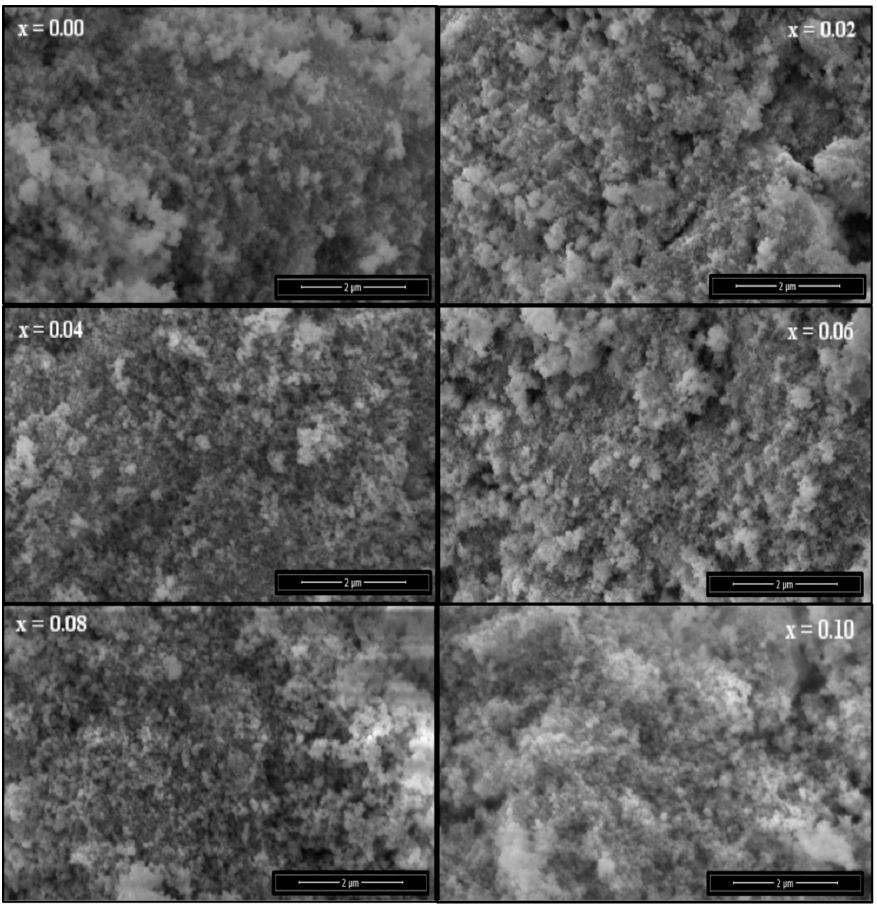
Figure 3. Scanning electron microscope (SEM) micrographs of the Co 0.5 Ni 0.5 Nb x Fe 2 − x O 4 (0.0 ≤ x ≤ 0.10) nanoparticles.